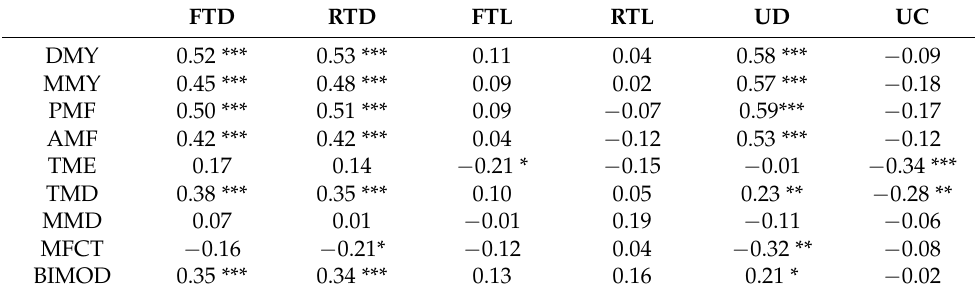
Table 4. Pearson correlation coefficient among udder and teat morphology and machine milking ability traits in Tunisian dairy